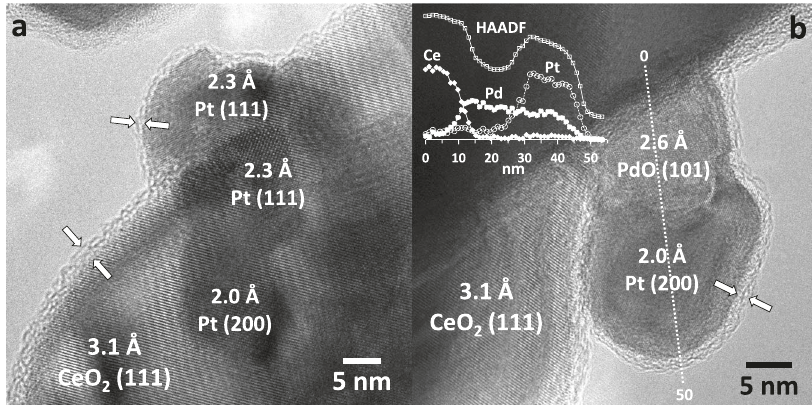
Fig. 6 | HRTEM images of PtPd-CeO 2 MM showing the amorphous shell. a Fresh PtPd-CeO 2 MM and b after methane combustion under a wet atmosphere at 723K for